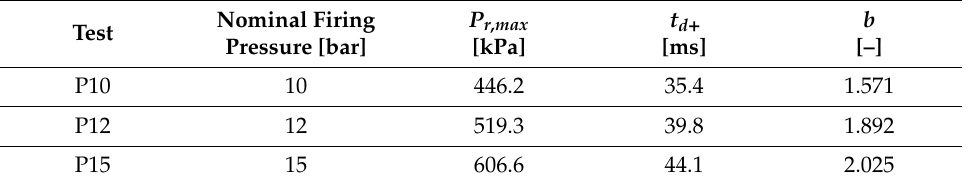
Table 7. Parameters of the Friedlander equation curve-fitted to the pressure measurements from massive plates tests.